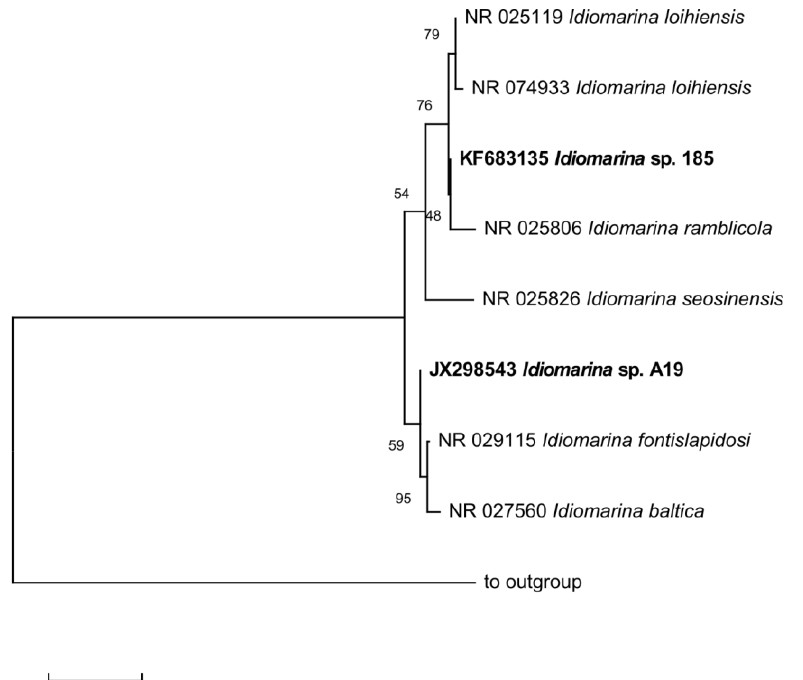
Figure 3. Rooted phylogenetic tree calculated by Tajima – Nei method distance estimation algorithm [28] showing affiliation of most representative bacterial isolates to closest-related sequences from either cultivated or cloned bacteria. The evolutionary history was inferred using the Neighbor-Joining method [29]. The tree was outgrouped with 16S rRNA gene sequence of Methanocaldococcus jannaschii DSM2661. Representative isolates are indicated in bold.